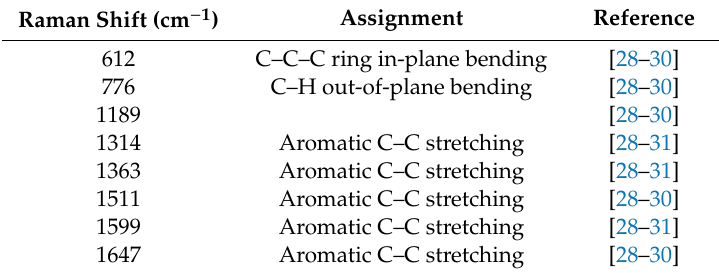
Figure 2. ( a ) Top view( upper ) and cross-section( below ) SEM images of (1) normally deposited Ag film and (2–5) Ag nanorods arrays deposited at different rates of 1, 1.7, 2.4, and 3.1 Å/s, respectively. Si/SiO 2 was used for the substrate. ( b ) SERS spectra of R6G absorbed on Ag in ( a ). ( c ) SERS efficiency of each Ag substrate. Table 2. Assignment of Raman bands in spectra of R6G.